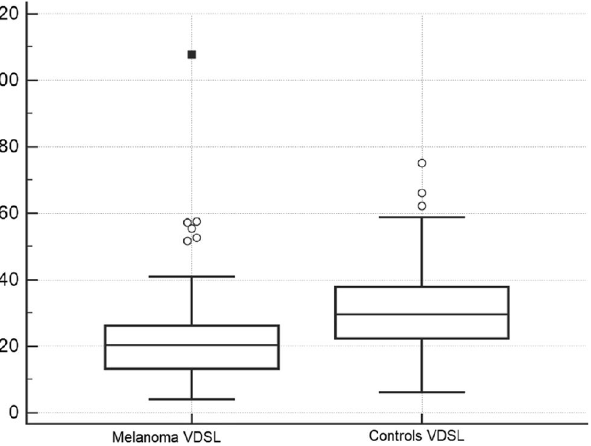
Figure 1. Comparison of VDSL (vitamin D serum levels) in melanoma (n. 154 subjects) and control group (n. 125 subjects) p < 0.0001.